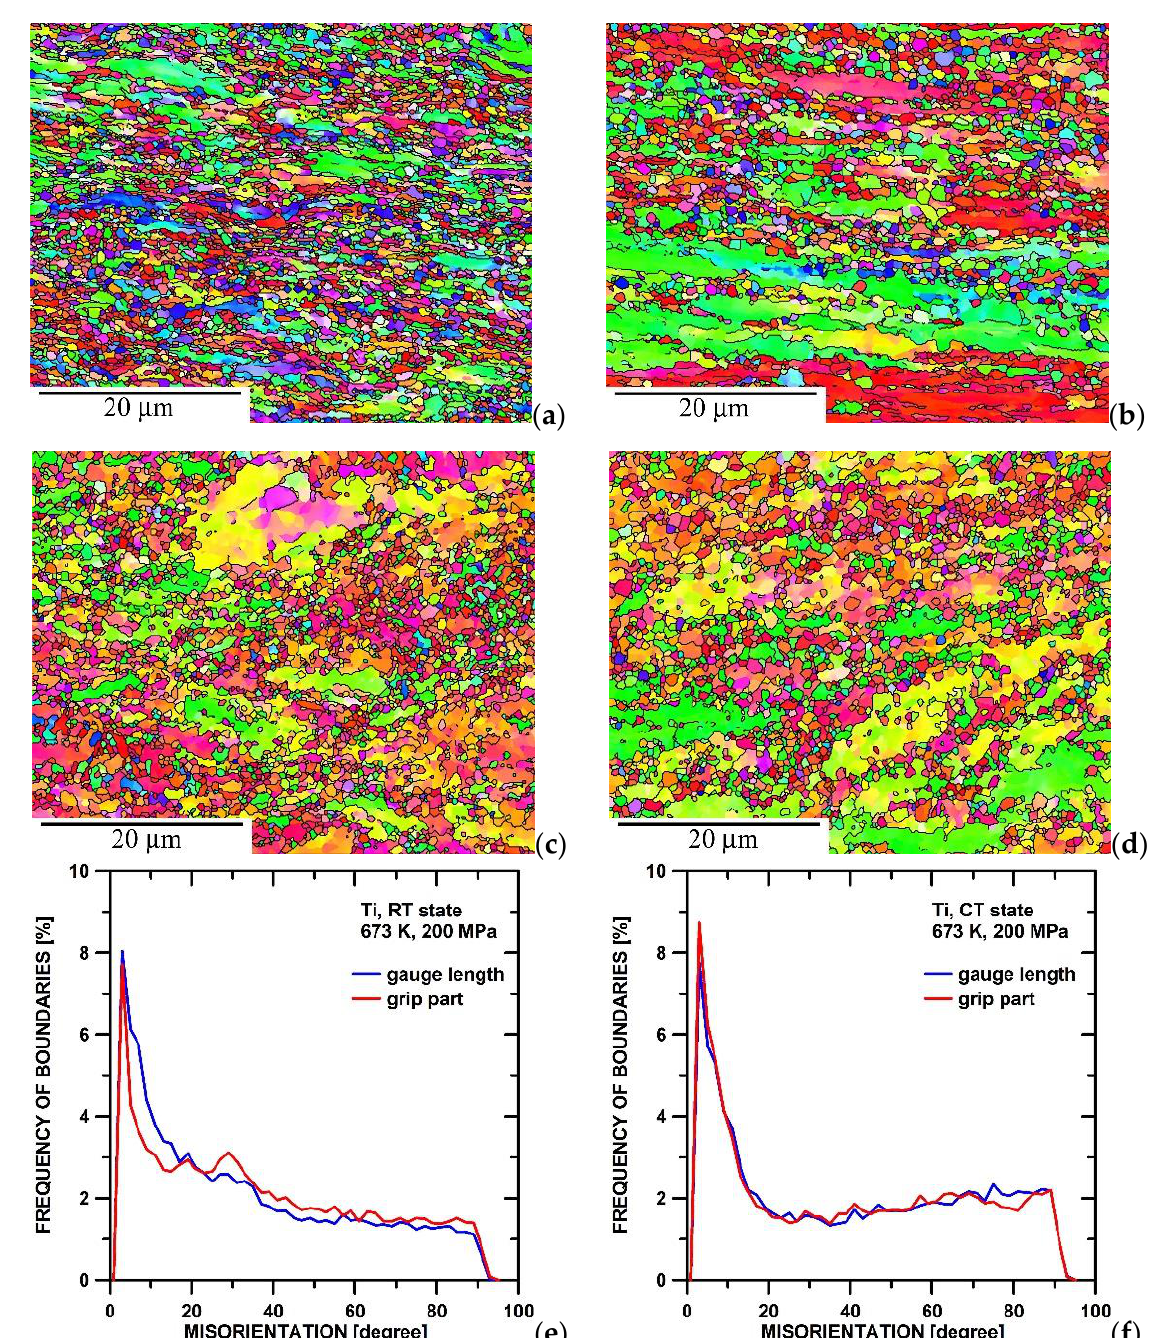
Figure 6. Microstructure of Ti after creep testing at 673 K and 200 MPa, ( a ) stress-free grip part of RT state, ( b ) gauge length of RT state, ( c ) grip part of CT state, ( d ) gauge length of CT state, ( e ) comparison of misorientation distributions of RT state after creep exposure, and ( f ) comparison of misorientation distributions of CT state after creep exposure.